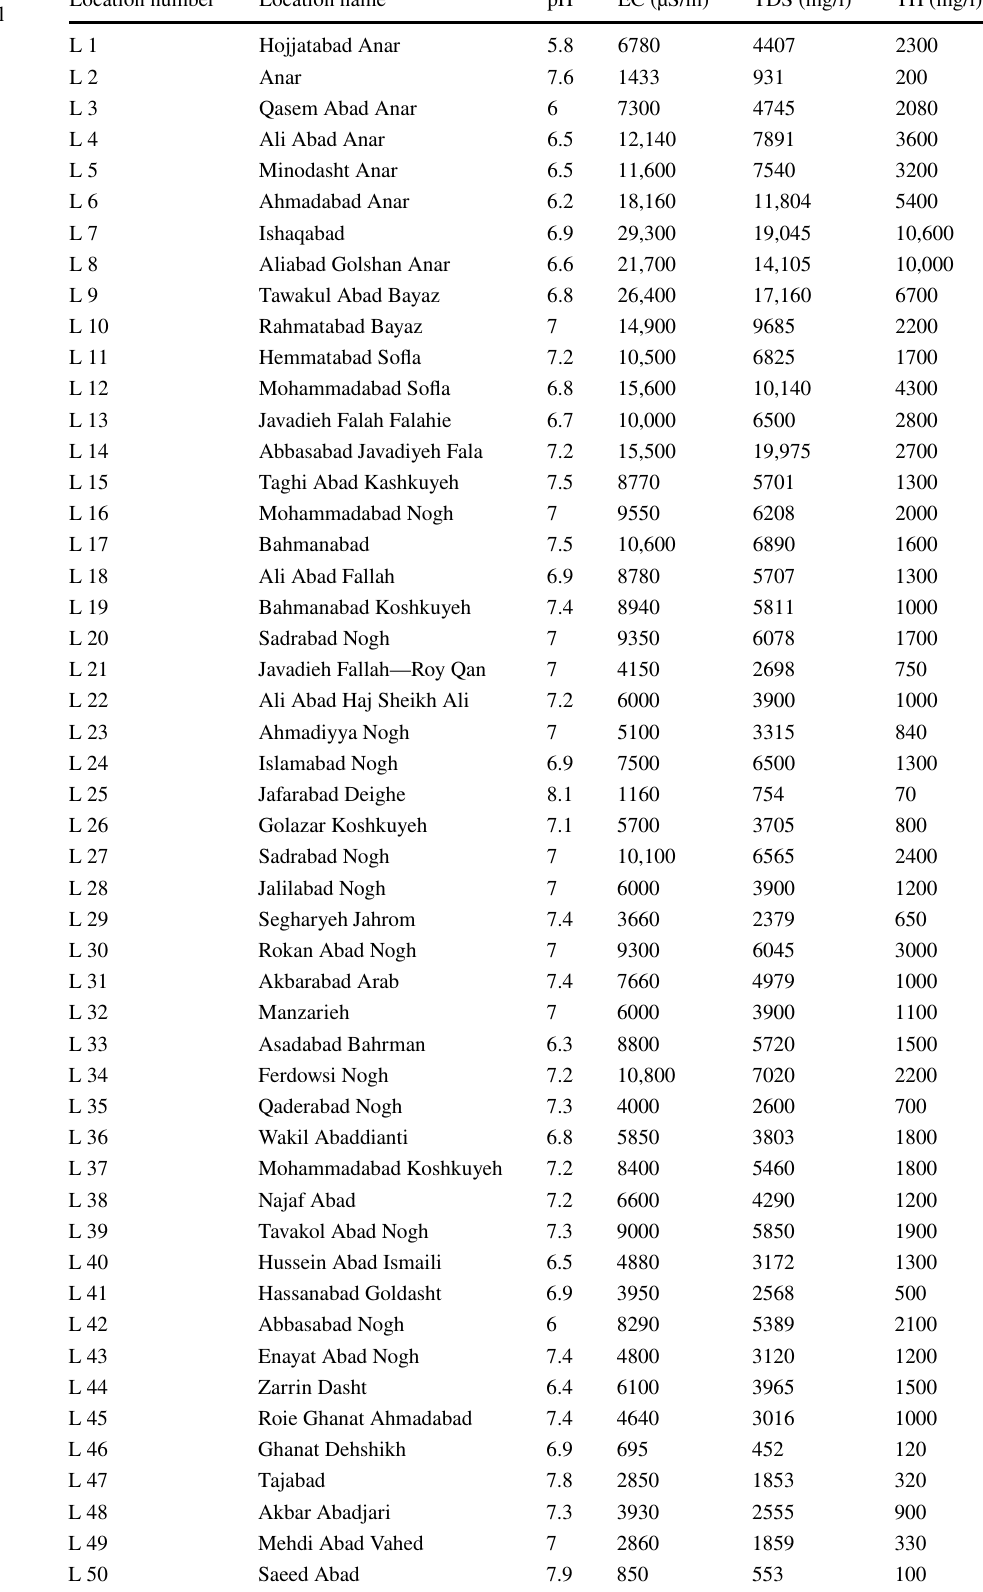
variations of physicochemical parameters in groundwater